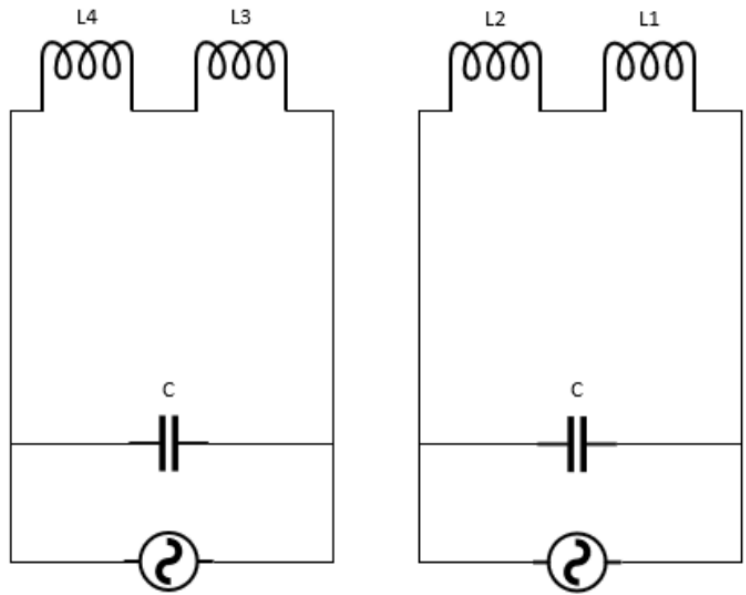
Figure 14. The experimental set-up with all 4 sets of coils connected in 2 sets for 2 heaters. Once the design with two sets of copper wire was in place, the two heat inductors were fitted to a large baking hull, as shown in Figure 15, and we adjusted the appropriate Joule frequency for this new wire unit to allow the maximum current to be drawn.